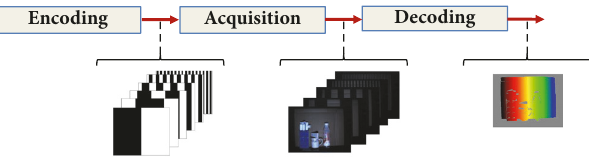
Figure 2: The overview of three basic steps in the process of a structured light system